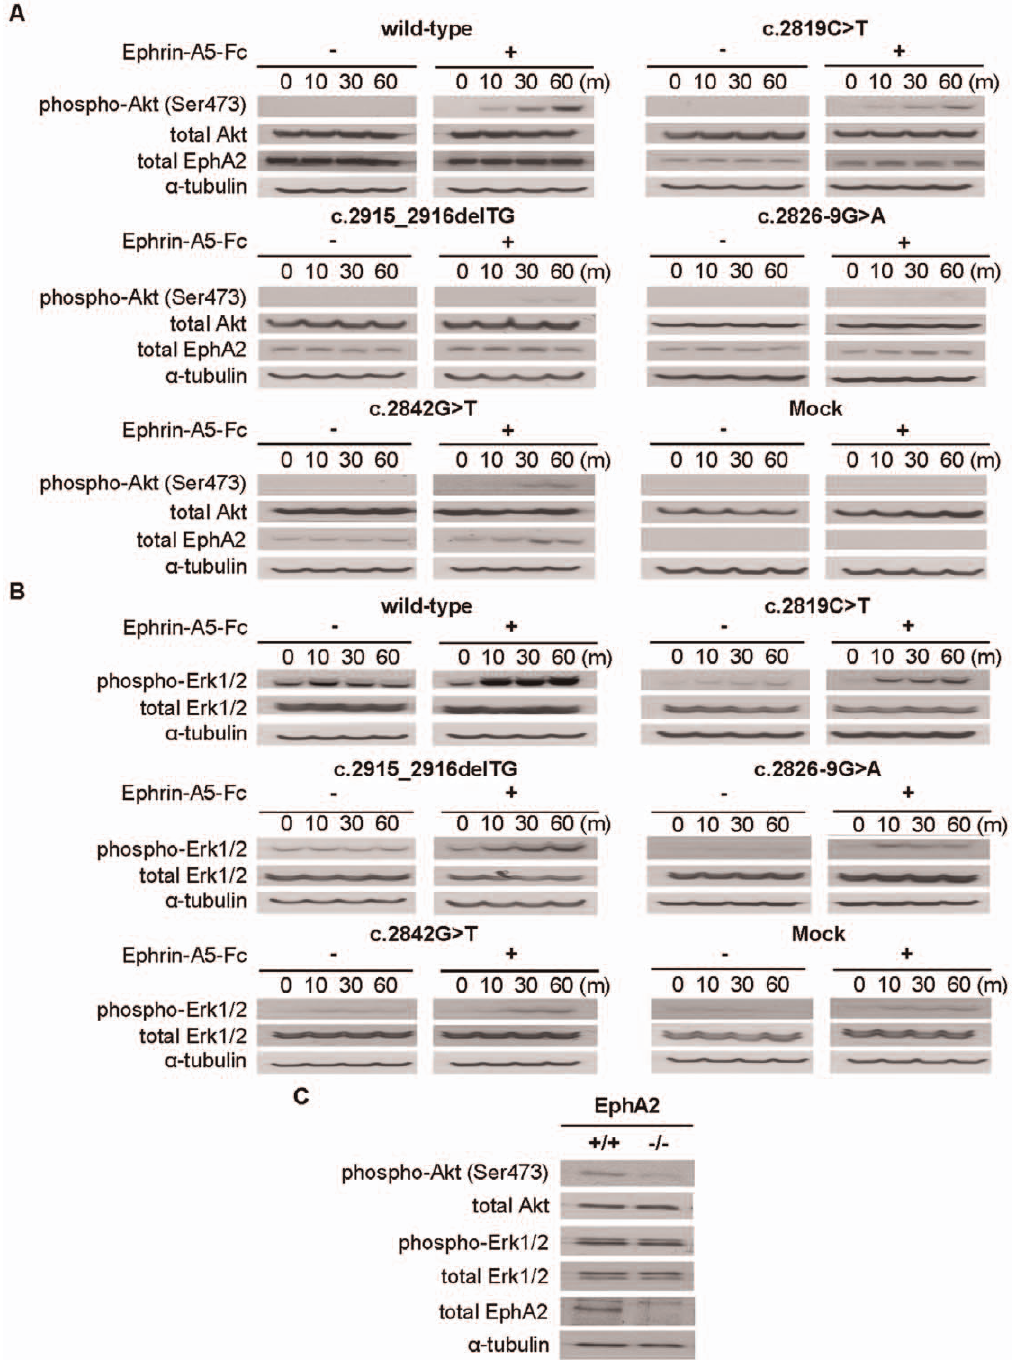
Figure 6. Ligand-stimulated EPHA2 activation regulates Akt and Erk activation. ( A, B ) Mutant EPHA2 proteins exhibit reduced activation of Akt and Erk by ephrin-A5. HEK293T cells were grown to confluence and serum-starved for 24 hours. 2 m g/mL cross-linked ephrin-A5-Fc was then added to the starvation media and cell lysates were immunoblotted with anti-phospho-Akt (Ser473) or anti-phospho-Erk (1/2), and then reprobed with anti- a -tubulin as a loading control. ( C ) Inactivation of EphA2 gene leads to reduction of Akt activity in mouse lenses. Each lens was prepared from 22 days old mice and extracted with lysis buffer. Total lens proteins were resolved by SDS-PAGE and western blot analysis was performed using indicated antibodies as described in the Materials and Methods. The blot was reprobed with anti- a -tubulin as a loading control.